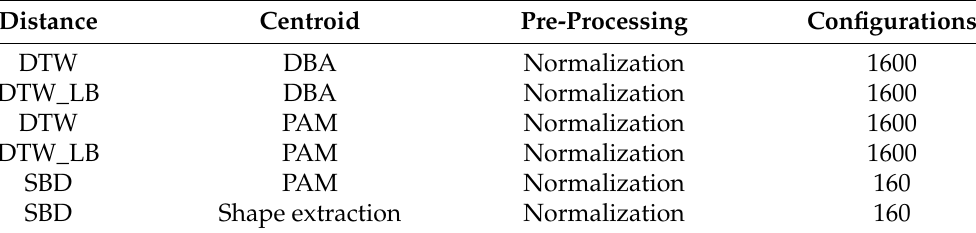
Table 1. Combinations of distances and centroid extraction methods tested and compared. References: DTW, Dynamic Time Warping; DTW_LB, Dynamic Time Warping Lower Bounds; DBA, DTW Barycenter Averaging; PAM, Partition Around Medoids; SBD, Shape Based Distance. Distance Centroid Pre-Processing Configurations DTW DBA DTW_LB